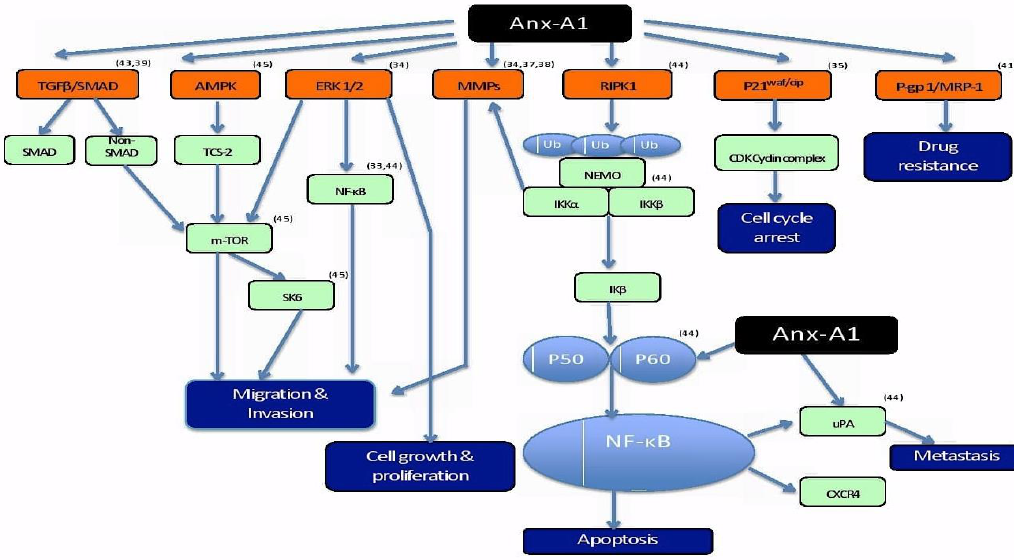
Figure 2. Schematic representation of di ff erential roles of Anx-A1 in various signaling pathways contributing to the pathophysiology of cancer [47–50].